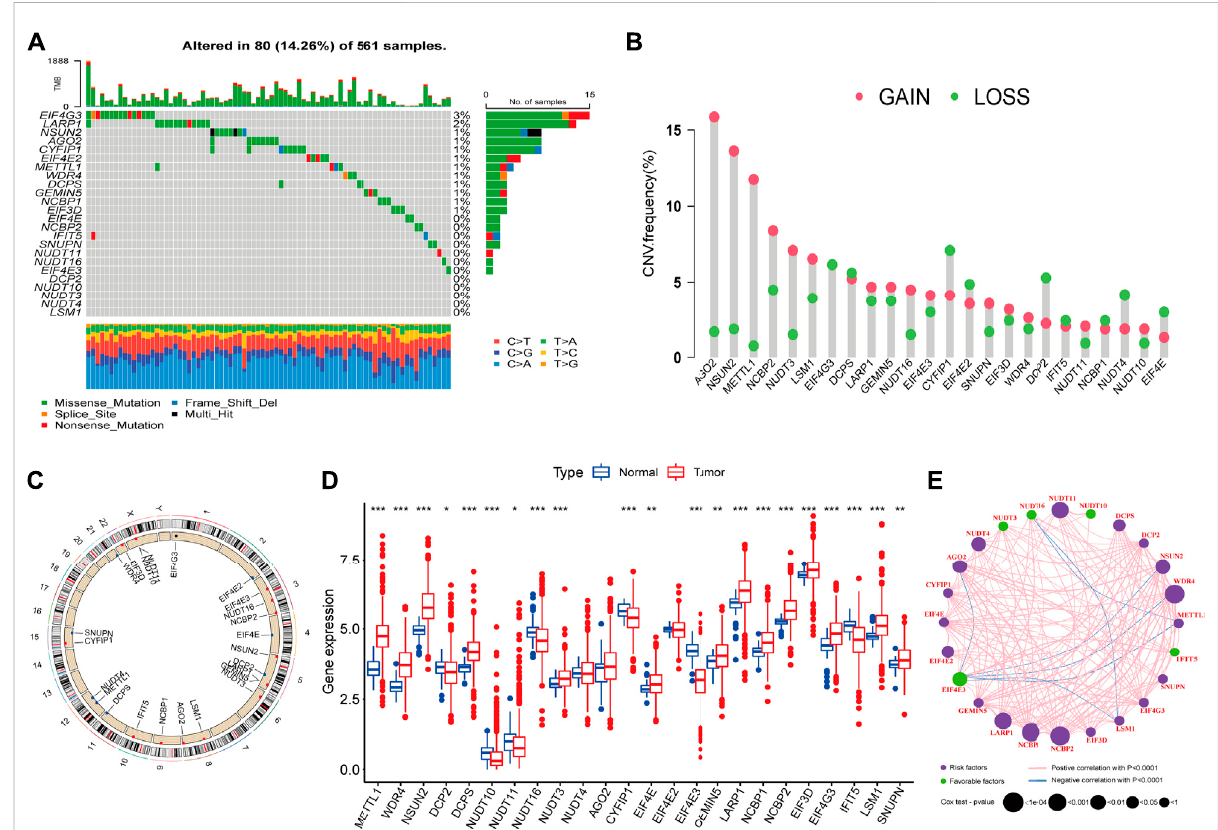
FIGURE 2 Landscape of genetic and expression variation of m 7 G regulators in lung adenocarcinoma (LUAD). (A) The mutation frequency of 24 m 7 G regulators in 561 patients with LUAD from TCGA-LUAD cohort, and each column represents individual patients. The top barplot depicts tumor mutation burden and mutation frequency in each regulator is given on the right. The right barplot depicts the proportion of each variant type. The stacked barplot below depicts fraction of conversions in each sample. (B) The copy number variation (CNV) alteration frequency of m 7 G regulators in TCGA-LUAD cohort. The height of each column represents the alteration frequency (Red dot: the ampli fi cation frequency; green dot: the deletion frequency). (C) The location of CNV alteration of m 7 G regulators on 23 chromosomes using TCGA-LUAD cohort. (D) The expression of m 7 G regulators between normal tissues and LUAD tissues (Red: tumor; blue: normal). The horizontal line indicates the median, the lower and upper boundariesoftheboxestheinterquartilerange,andthedotstheoutliers.Asterisksindicatestatisticalsigni fi cance,* p < 0.05,** p < 0.01,*** p < 0.001. (E) The interaction between m 7 G regulators in LUAD. Each regulator is represented as a circle, where the size of the circle represents the effect of each regulator on the prognosis, and p values were calculated by Log-rank test (* p < 0.05, ** p < 0.01, *** p <